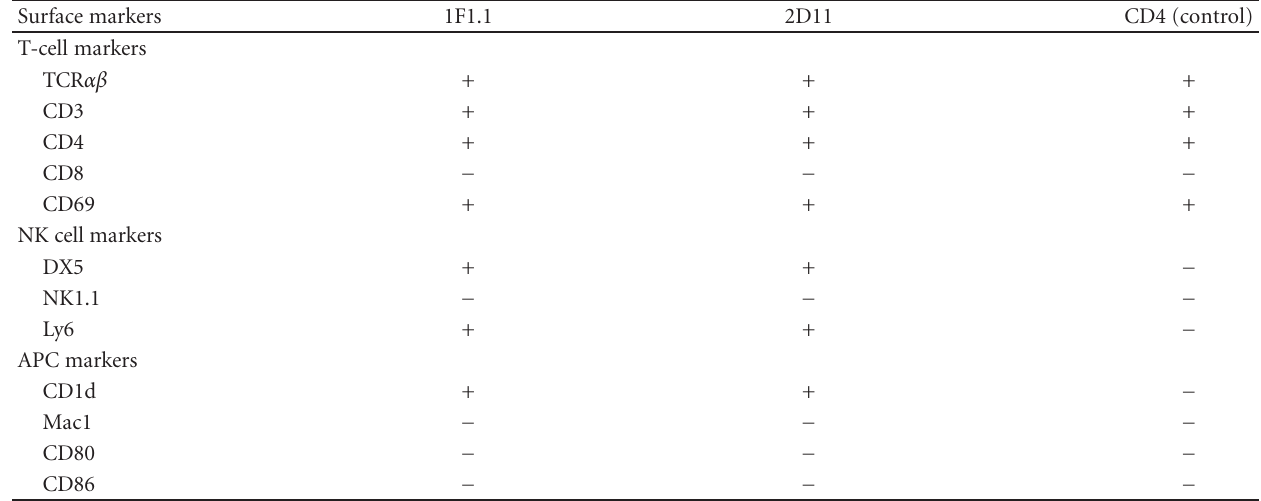
Table 2: Surface phenotype of two lines of iNKT cells. Both lines expressed markers for T and NK cells. Surface